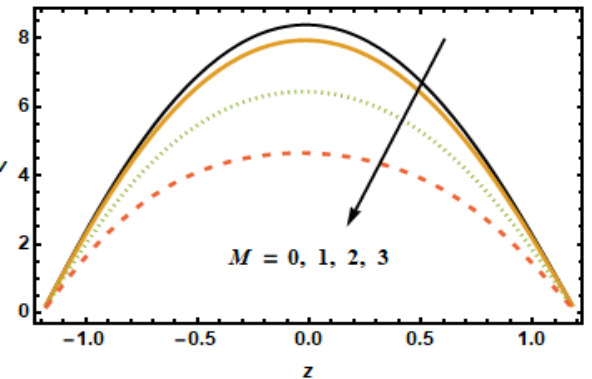
Figure 8. Dependence of v on Hartman number M